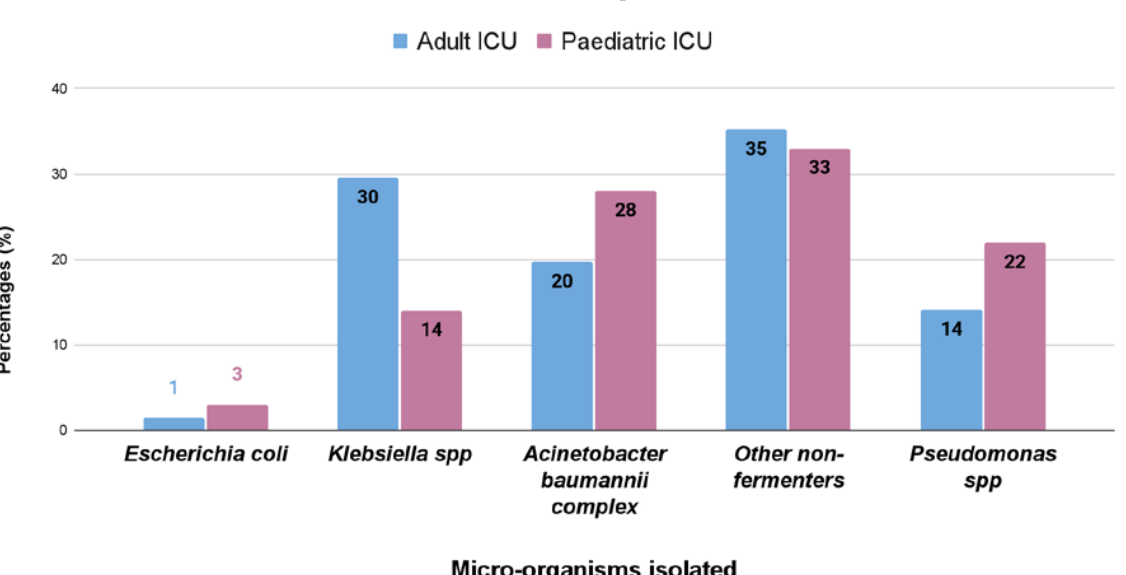
Figure 2. Percentage (%) of different bacterial isolates obtained from respiratory samples of the adult and pediatric intensive care units.